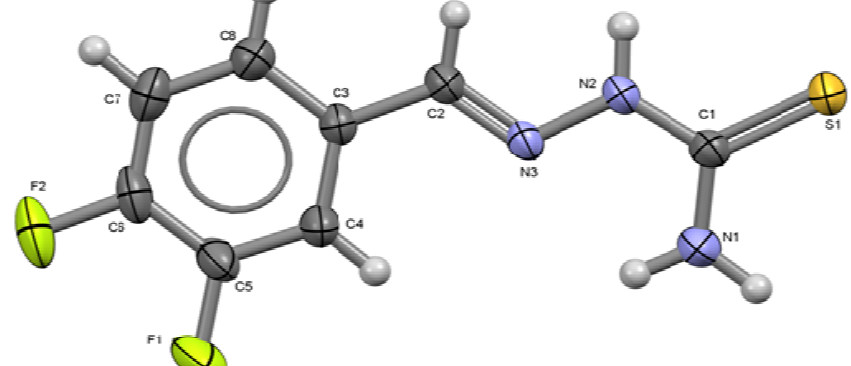
H F -CH=N-NH-C(S)NH ( 4 ). Thermal ellipsoids are 6 3 2 2